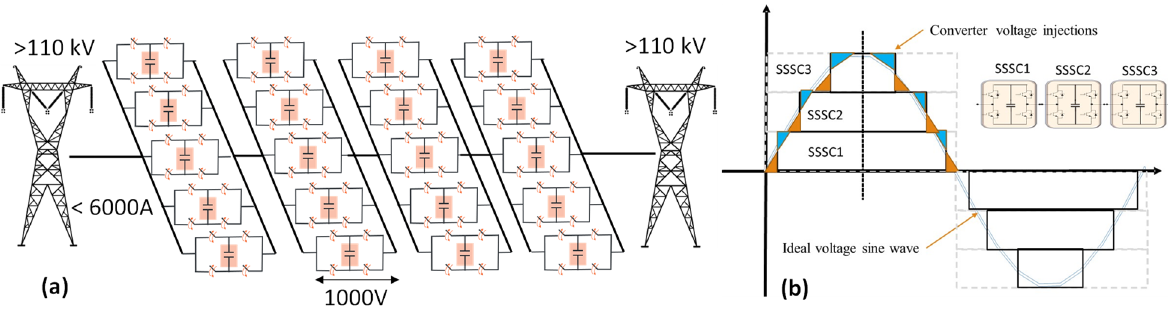
Figure 4. Modular SSSC scheme ( a ) diagram ( b ) 3-seres SCCC single